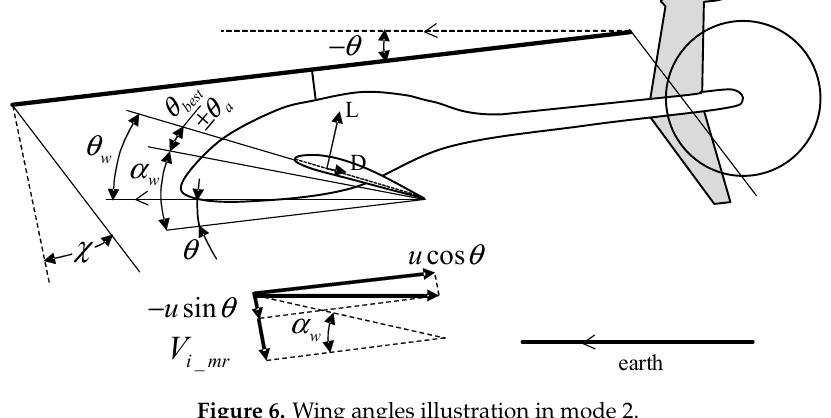
Figure 6. Wing angles illustration in mode 2.